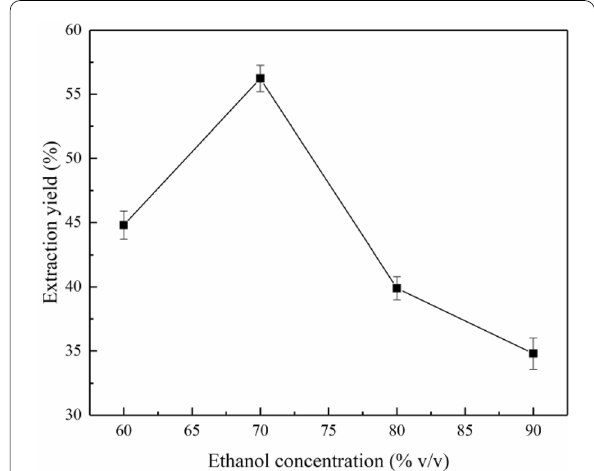
Fig. 3 Effect of the extraction temperature on the lignin extraction yield under the extraction conditions of 120 min reaction time using 70% ethanol at 1:15 g/mL solid/liquid ratio